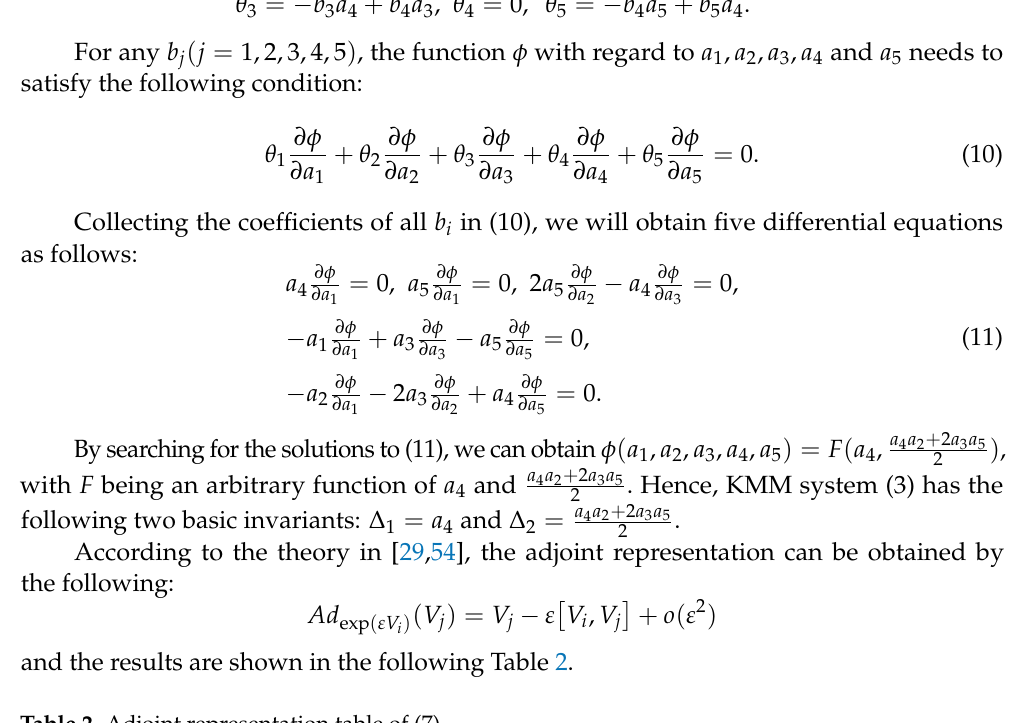
Table 2. Adjoint representation table of